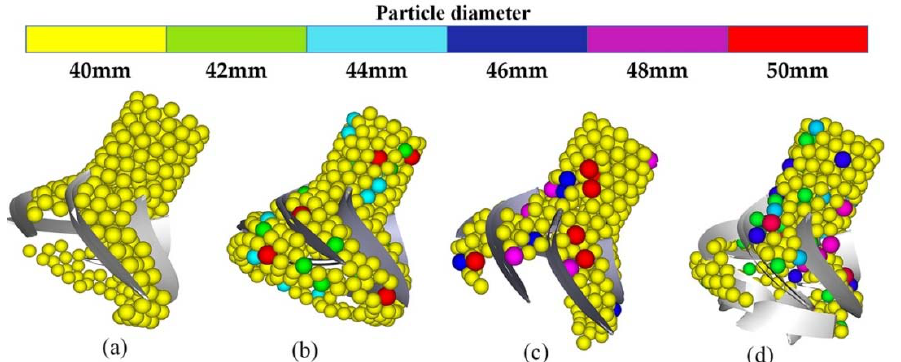
Figure 16. Different particle size distributions that lead to blockages with different degrees: ( a ) single-particle size of 40 mm; ( b ) particle size distribution of 40, 42, 44, and 50 mm; ( c ) particle size distribution of 40, 46, 48, and 50 mm; ( d ) particle size distribution of 40, 42, 44, 46, 48, and 50 mm.